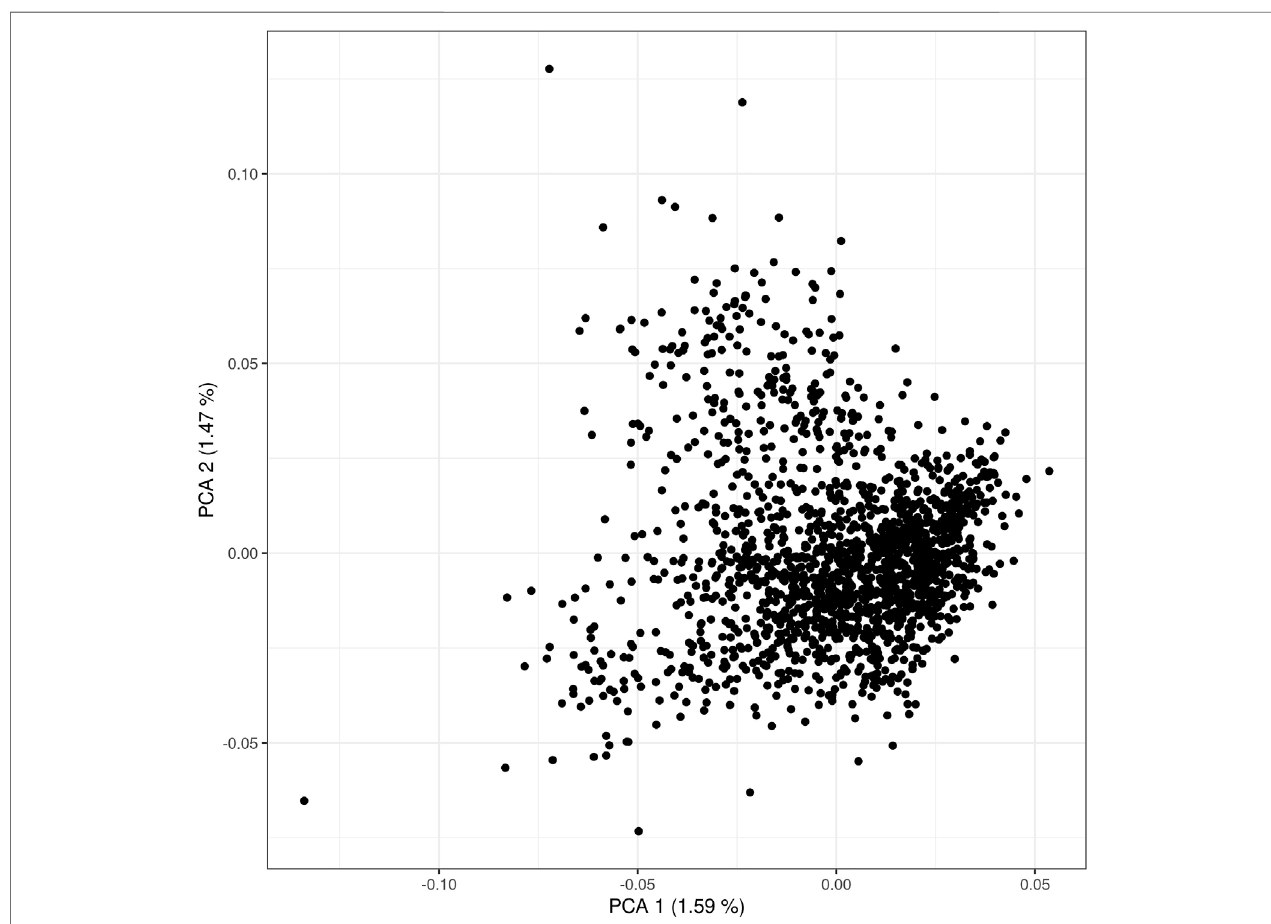
FIGURE 1 | Scatter plot of fi rst and second principal components of the genomic relationship matrix (the G matrix) used in the ssGBLUP. A total of 113,279 SNPs and 1,690 cattle were used to perform the principal component analysis.